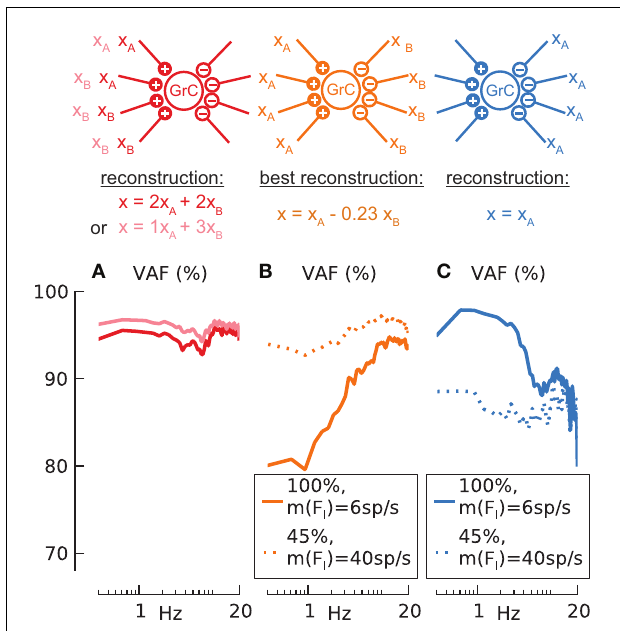
FIGURE 8 | Synaptic signal combination and signal trough inhibitory synapse. Reconstruction quality (VAF) (A–C) of N = 100 synaptically activated (AMPA + NMDA) granule cells with m ( F I ) = 6 spikes/s but different input configurations as depicted by clipart above. Mean, standard deviation of effective firing-rate in spikes/s and mean of VAF in % given as triplet [ m ( F eff )/ std ( F eff )/ m ( VAF )] in the following. Baseline condition for all following simulations: modulation amplitude a = 1. (A) Two different input signals to two excitatory synapses respectively (dark red line) (37/8.2/95.0) or to one and three excitatory synapses (light red line) (37/8.0/95.9). (B) Two different input signals to 4 excitatory and 4 inhibitory synapses respectively, best reconstruction x ( t ) = x A ( t ) − 0 . 23 x B ( t ) (solid orange line) (38/7.7/91.9). Additional simulations for reduced synaptic conductance (45%) and increased inhibition rate m ( F I ) = 40 spikes/s (dotted orange line) (38/6.3/96.1). (C) One input signal to the 4 inhibitory synapses only (solid blue line) (38/8.6/90.2). Additional simulations for reduced synaptic conductance (45%) and increased inhibition rate m ( F I ) = 40 spikes/s, (dotted blue line)